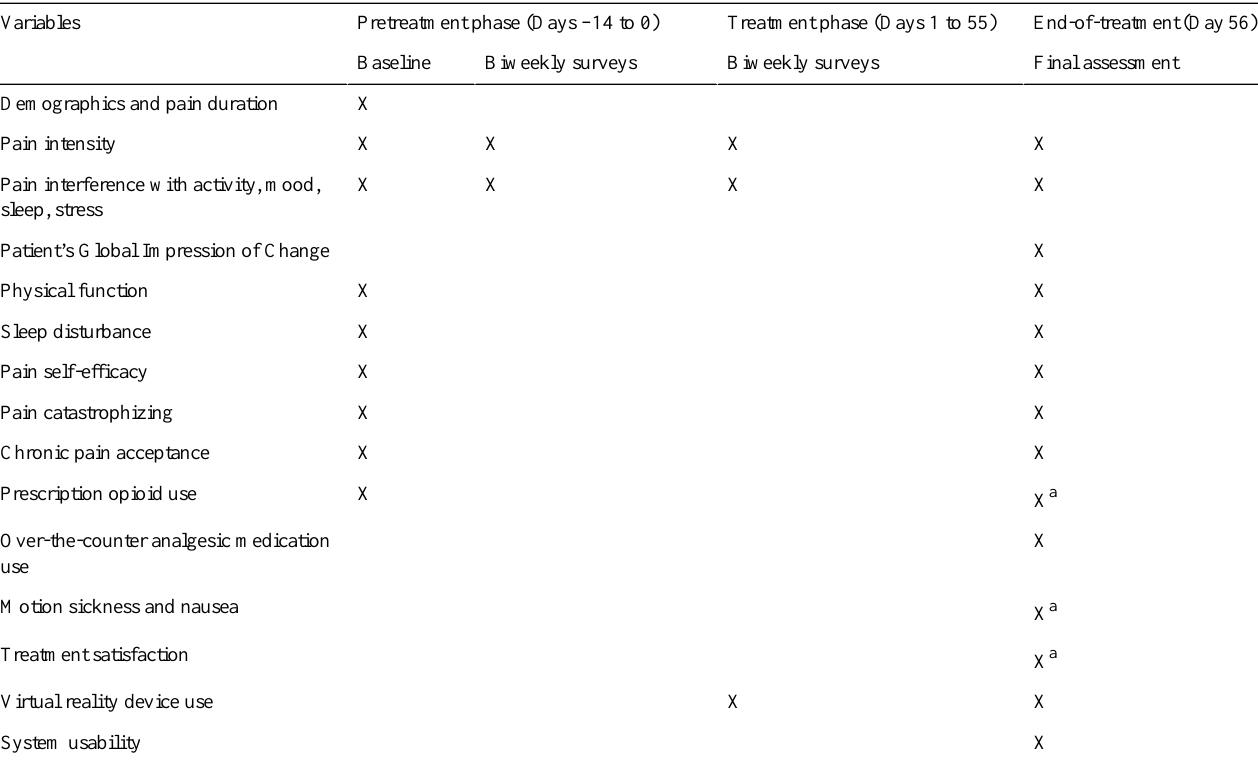
Table 1. Timeline of variable